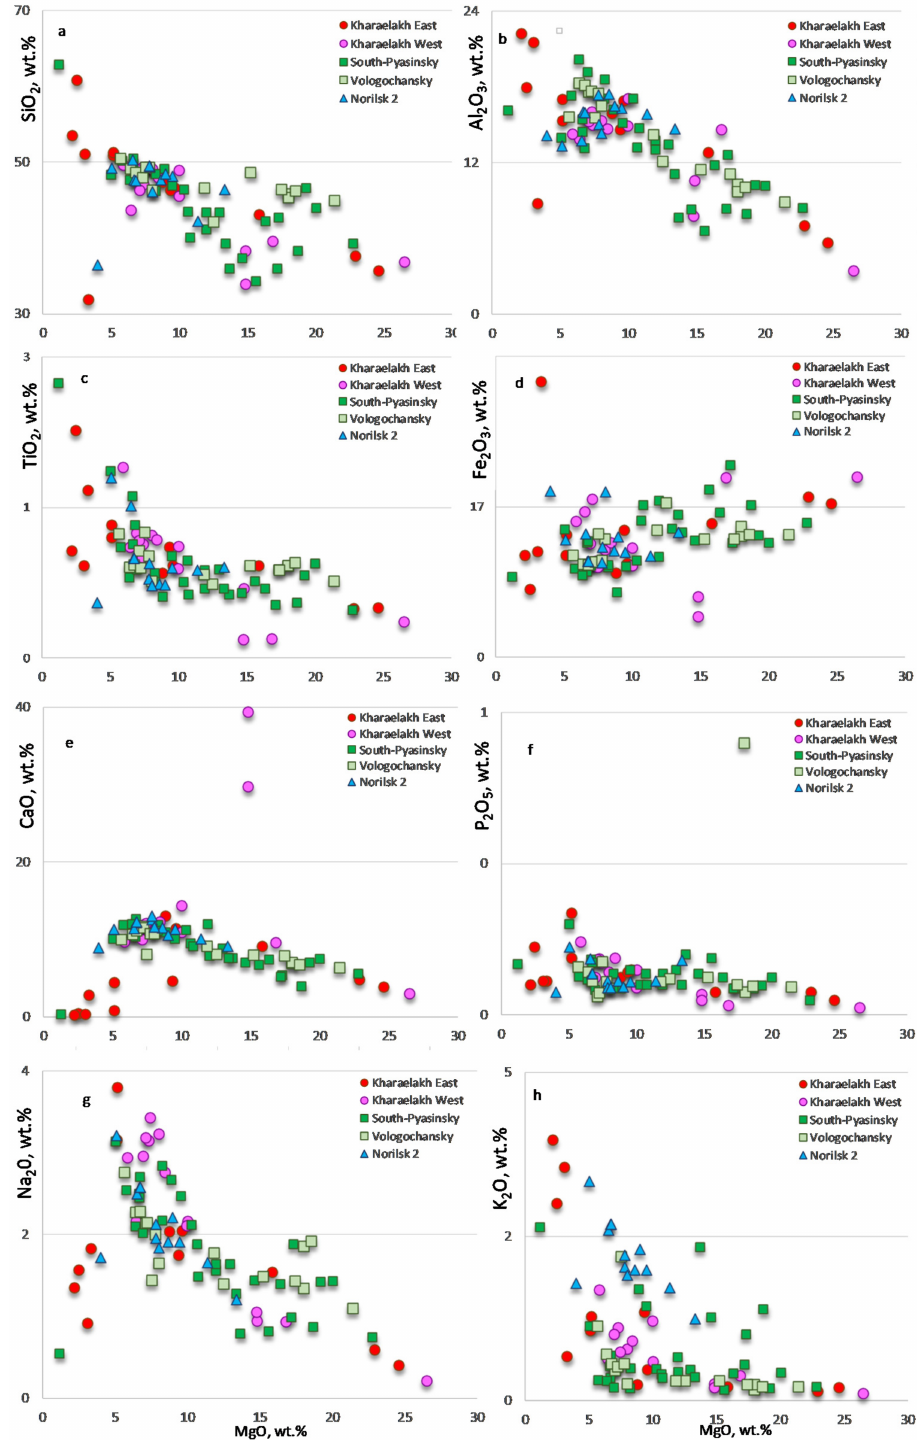
Figure 8. Diagrams of MgO vs. ( a ) SiO 2 , ( b ) Al 2 O 3 , ( c ) TiO 2 , ( d ) Fe 2 O 3 , ( e ) CaO, ( f ) P 2 O 5 , ( g ) Na 2 O, and ( h ) K 2 O for the rocks of the Norilsk